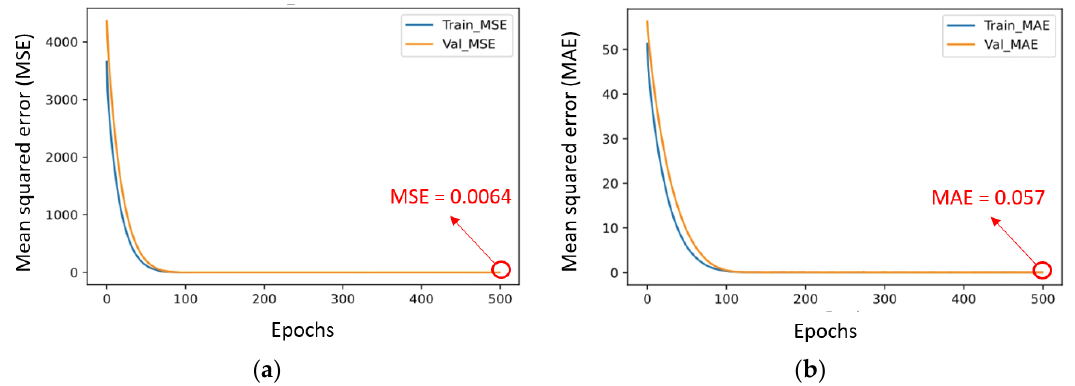
Figure 13. Training performances of the redesigned ANN: ( a ) MSE, and ( b )